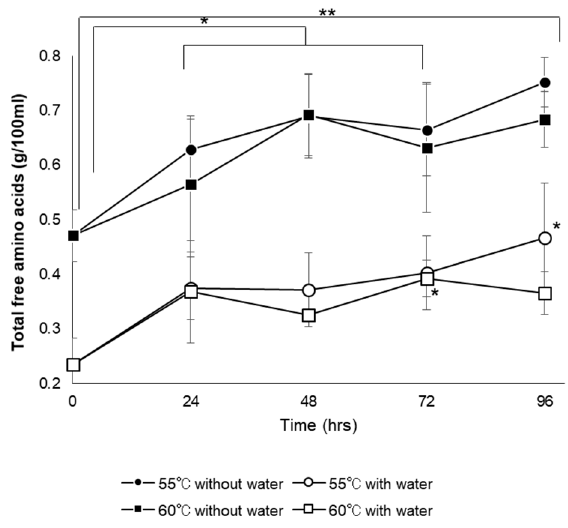
Figure 10. Total free amino acid content of the mixtures of masu salmon reacted at 55 °C and 60 °C or 96 h. Values represent mean ( n = 3). Asterisks mean significant different (*, p <0.05; **, P < 0.01).